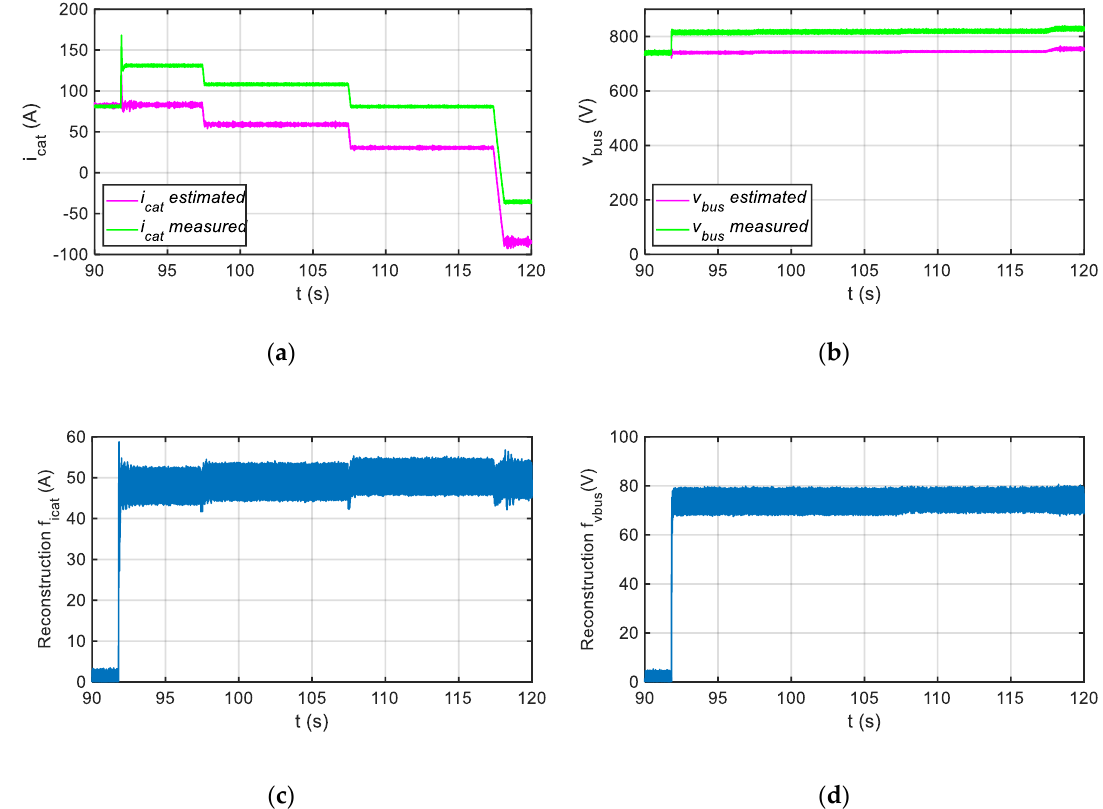
Figure 10. Injection of multiple sensor faults. ( a ) Measured and estimated catenary current. ( b ) Measured and estimated DC-link voltage. ( c ) Catenary current fault reconstruction. ( d ) DC-link voltage fault reconstruction.